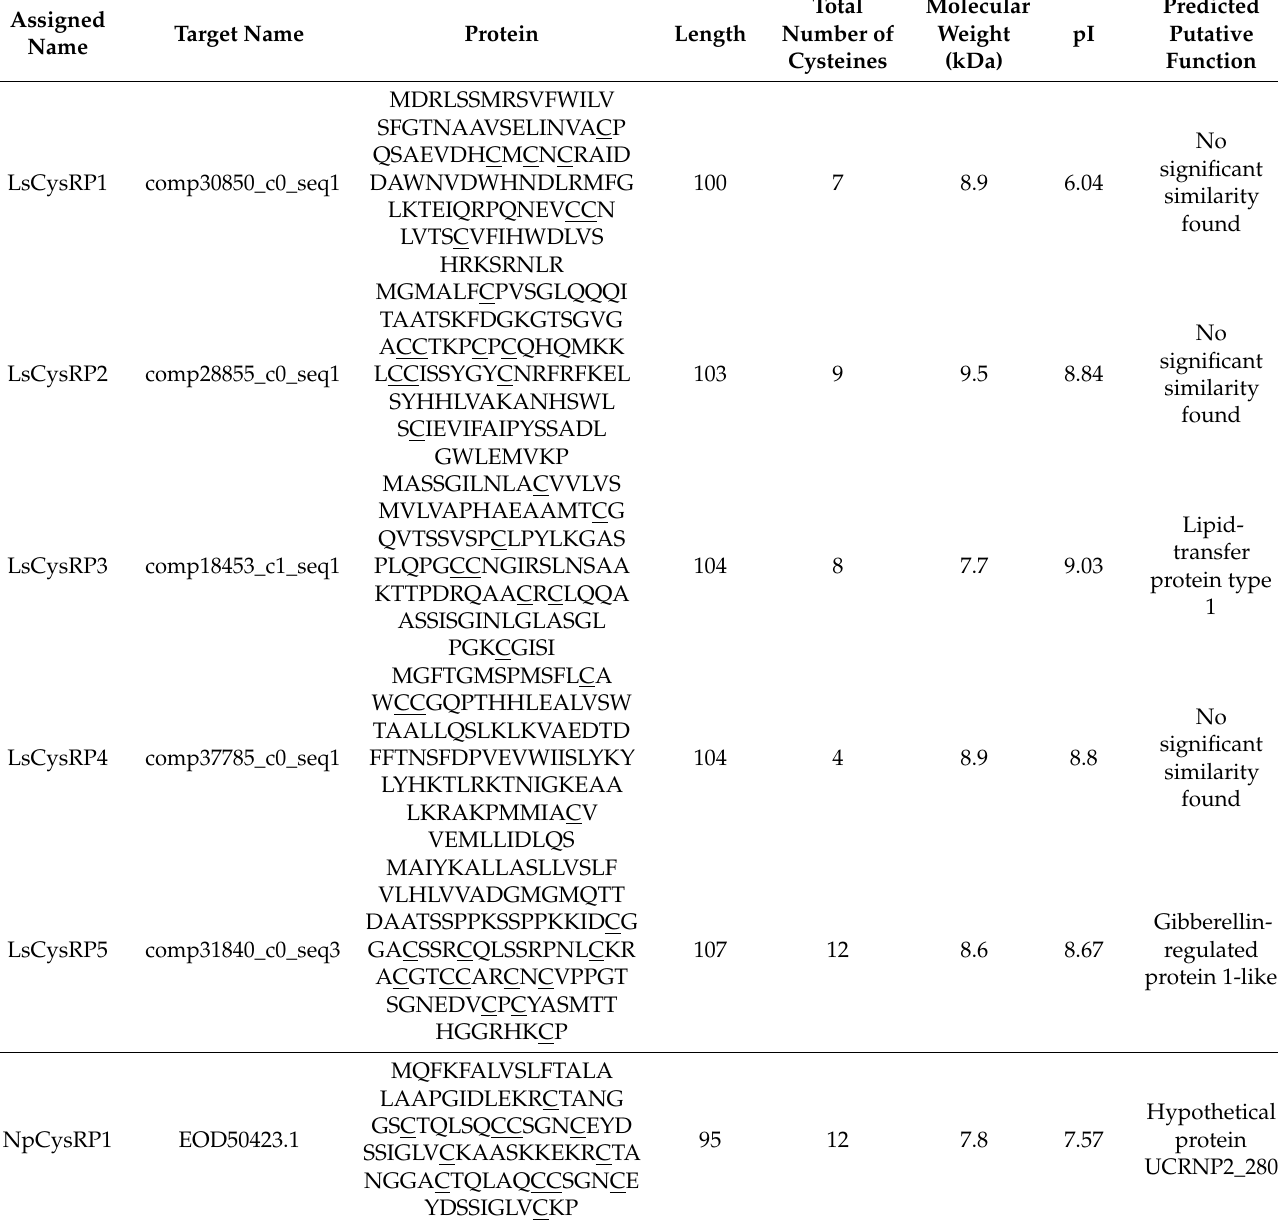
(Table S3). To determine whether the CysRPs have the potential for secretion, an analysis was conducted with the TargerP-2.0 server. All sequences, apart from the LysCysRP2 sequence, have a peptide signal between 17 and 27 amino acids. To corroborate these results, additional analyses were performed using the Protter and DeepLoc-1.0 servers, and the results indicated that all of the CysRPs have a signal peptide and are extracellular proteins (Table 2). Table 1. Amino acid sequences of L. styraciflua and N. parvum CysRP. Predicted putative function was inferred with BLAST and Motif prediction tools, molecular weight, and isoelectric point are theoretical predictions (see Materials and Methods). Cysteines are underlined in the amino acid